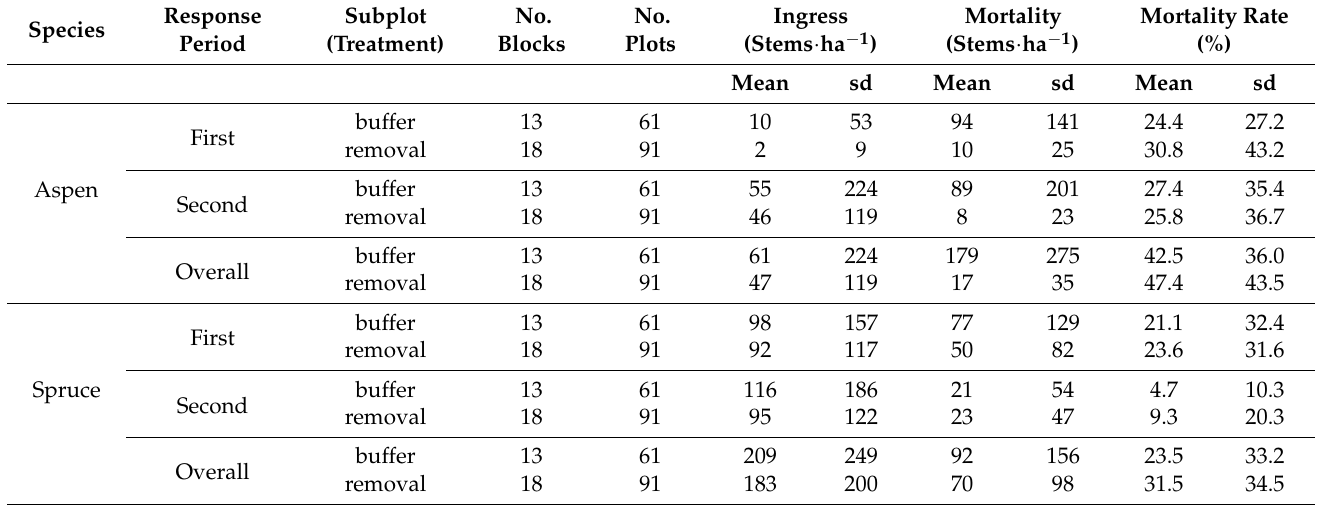
Table 6. Summary of mortality and ingress for aspen and spruce trees ( ≥ 7.1 cm DBH) over the three measurement periods. Note: There were different lengths of the first response period (between Measurements 1 and 2) of 5–7 years for different blocks, and the same length of the second response period (between Measurements 2 and 3) of 5 years across all blocks and plots. Subplots with no recorded trees were included in averaging (as zero density), but were not used in computation of the mortality rate.